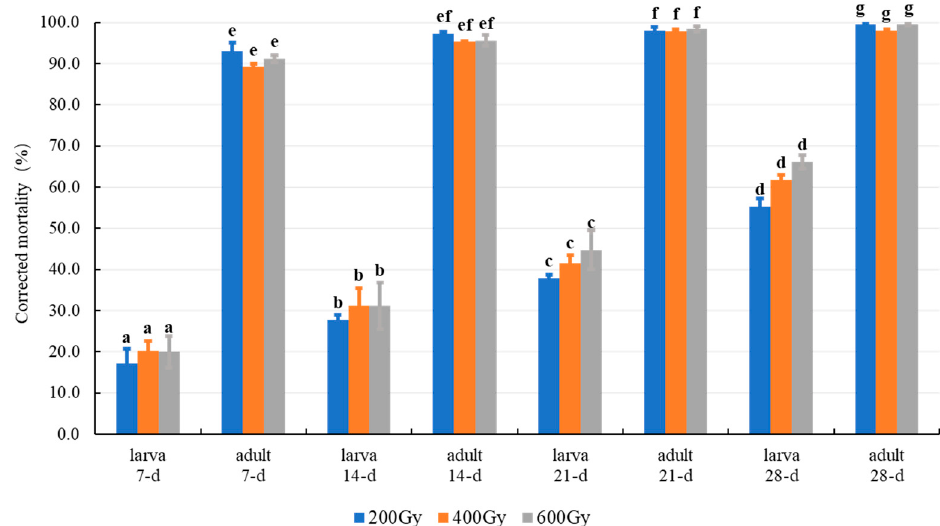
Figure 1. Percentage mortality of T. granarium adult and larvae treated with 200, 400, and 600 Gy gamma radiation for the duration of 7, 14, 21, and 28-d at 24–26 °C. Means ( ± SD) followed with different letters are significantly different ( p < 0.05; Tukey test).